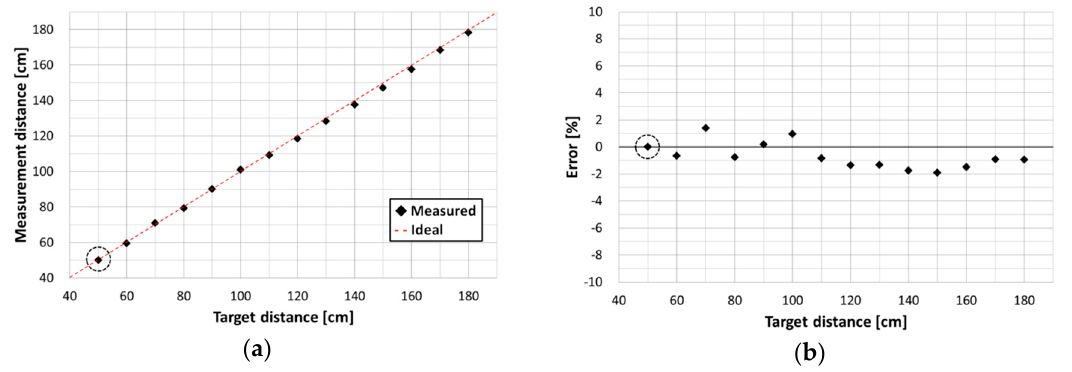
Figure 9. Measurement results of target distances at room temperature. ( a ) Measured distances to the target reflector as a function of actual target distance, based on the result obtained at 50 cm; ( b ) Measurement errors as a function of target distance, based on the result obtained at 50 cm.